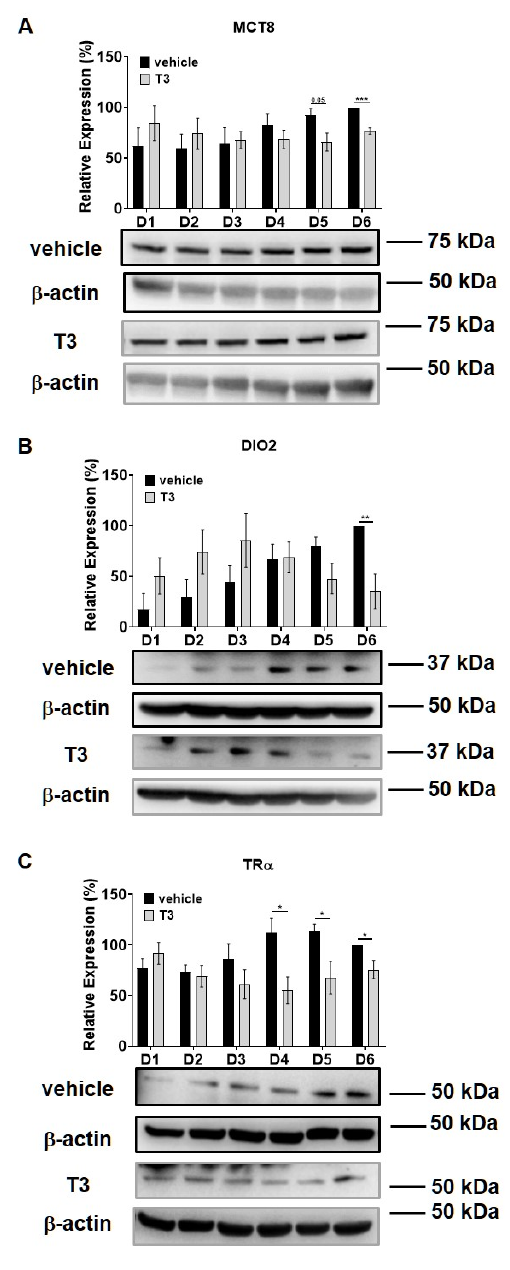
Figure 2. MCT8, DIO2 and TR α expression throughout the differentiation of C2C12 myoblasts in the presence of T 3. ( A – C ) Myoblasts were differentiated for 6 days receiving either 10 nM T 3 or equal amounts of HCl:EtOH solution. Proteins from whole-cell lysates were analyzed using Western blot with anti-MCT8 ( A ), anti-DIO2 ( B ) and anti-TR α ( C ) antibodies. Values represent n = 4–5, mean ± SEM. Data were normalized to the Day 6 vehicle control. Differences between group means were determined using Two-way ANOVA followed by Sidak post hoc test and by multiple unpaired two-tailed t -tests, p < 0.05 (*), p < 0.01 (**), p < 0.001 (***).